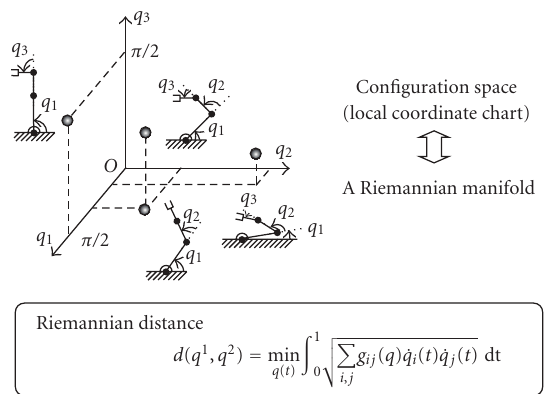
Figure 1: The set of all possible postures of a planar robot arm with three joints can be regarded as a Riemannian manifold with Riemannian metric g ij ( q ) that constitutes the inertia